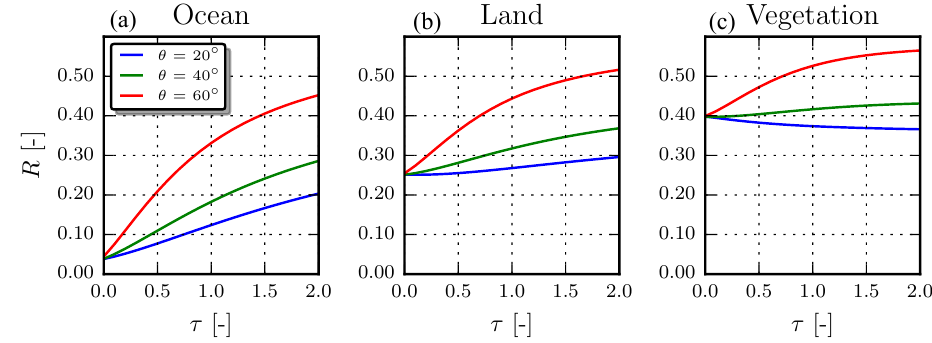
Figure 5. Top-of-atmosphere reflectance at 755nm, well outside the oxygen A band, from simulated spectra of scenes containing aerosols over dark and bright surfaces. Red, blue, and green lines represent different viewing zenith angles θ , as a function of increasing aerosol optical thickness. Aerosols have a single-scattering albedo of 0.95, and the aerosol scattering is described by a Henyey–Greenstein phase function with g = 0.7. Aerosol layer is situated at 925hPa. The solar zenith angle is 45 ◦ and a relative azimuth angle is 0 ◦ . (a) The surface albedo is 0.03 at 760nm, typical over the ocean. (b) The surface albedo is 0.25 at 760nm, typical over land. (c) The surface albedo is 0.4 at 760nm, typical over vegetated